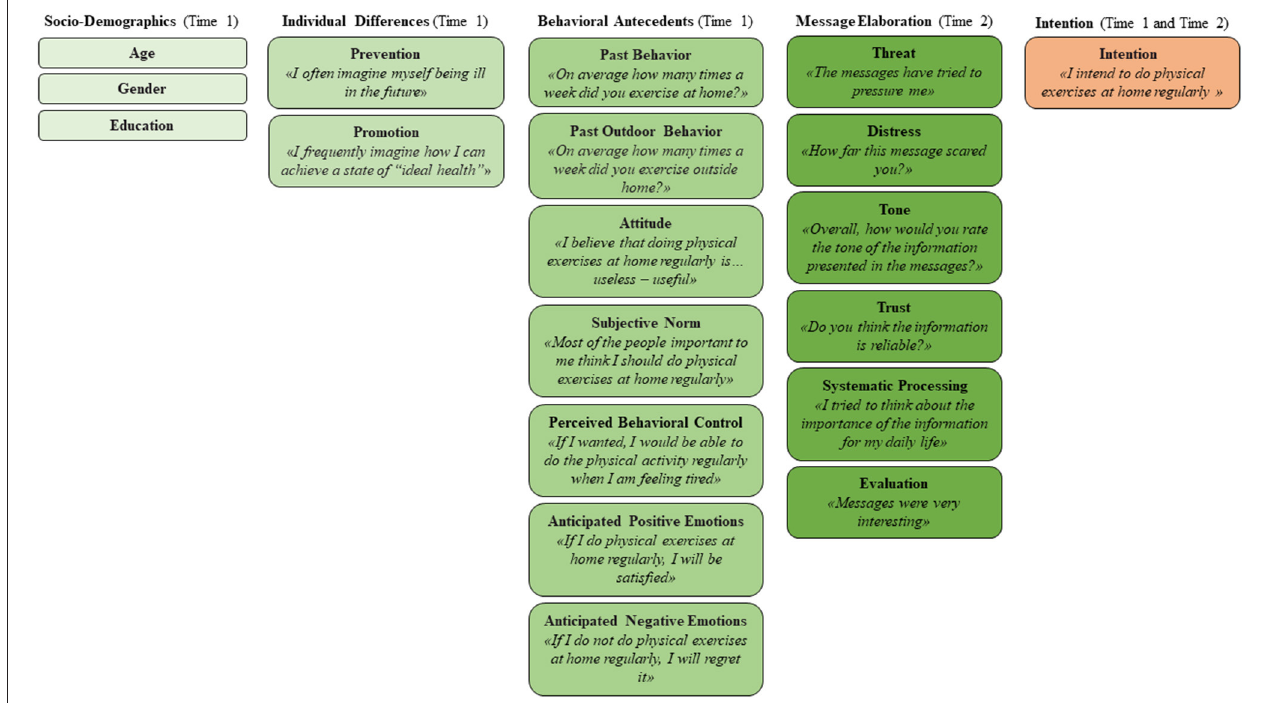
FIGURE 1 | Psychosocial predictors of change in the intention to exercise at home, with examples of the measures employed.